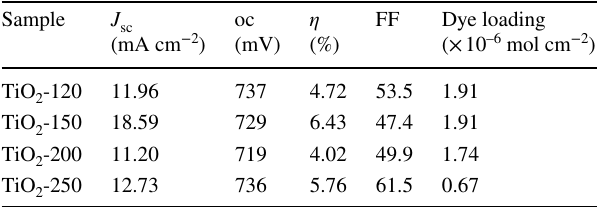
Fig. 6 EIS analysis of dye-sensitized solar cells with mesoporous TiO 2 2